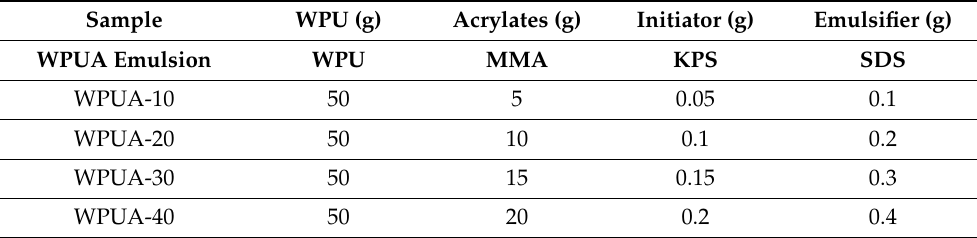
Table 1. The recipes for WPUA